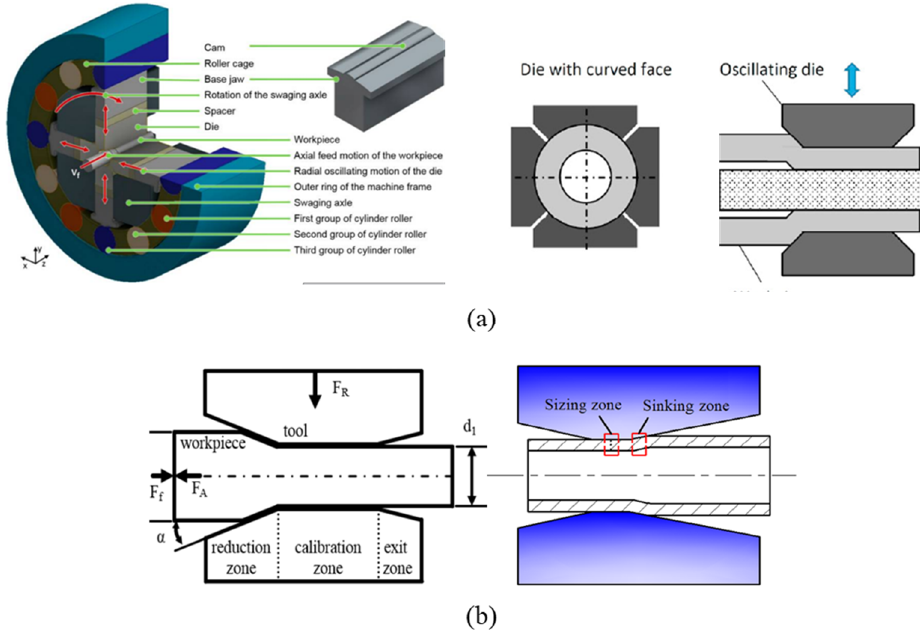
Figure 1. ( a ) A Lebel diagram of a swaging head [2] and ( b ) the zones of the swaging process [3], with permission from Elsevier, 2020.